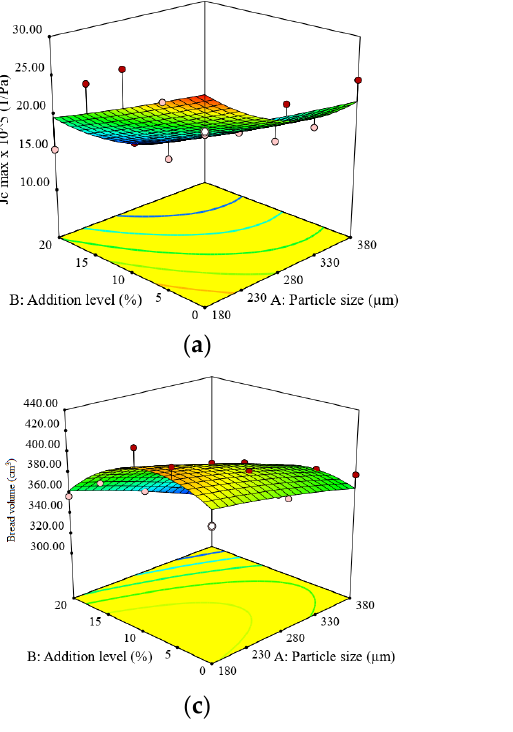
Figure 6. 3D response surface graphic presenting the effect of quinoa flour particle and addition level on: ( a ) maximum creep test (Jc max ); ( b ) maximum recovery test (Jr max ); ( c ) bread volume (BV); ( d ) bread firmness